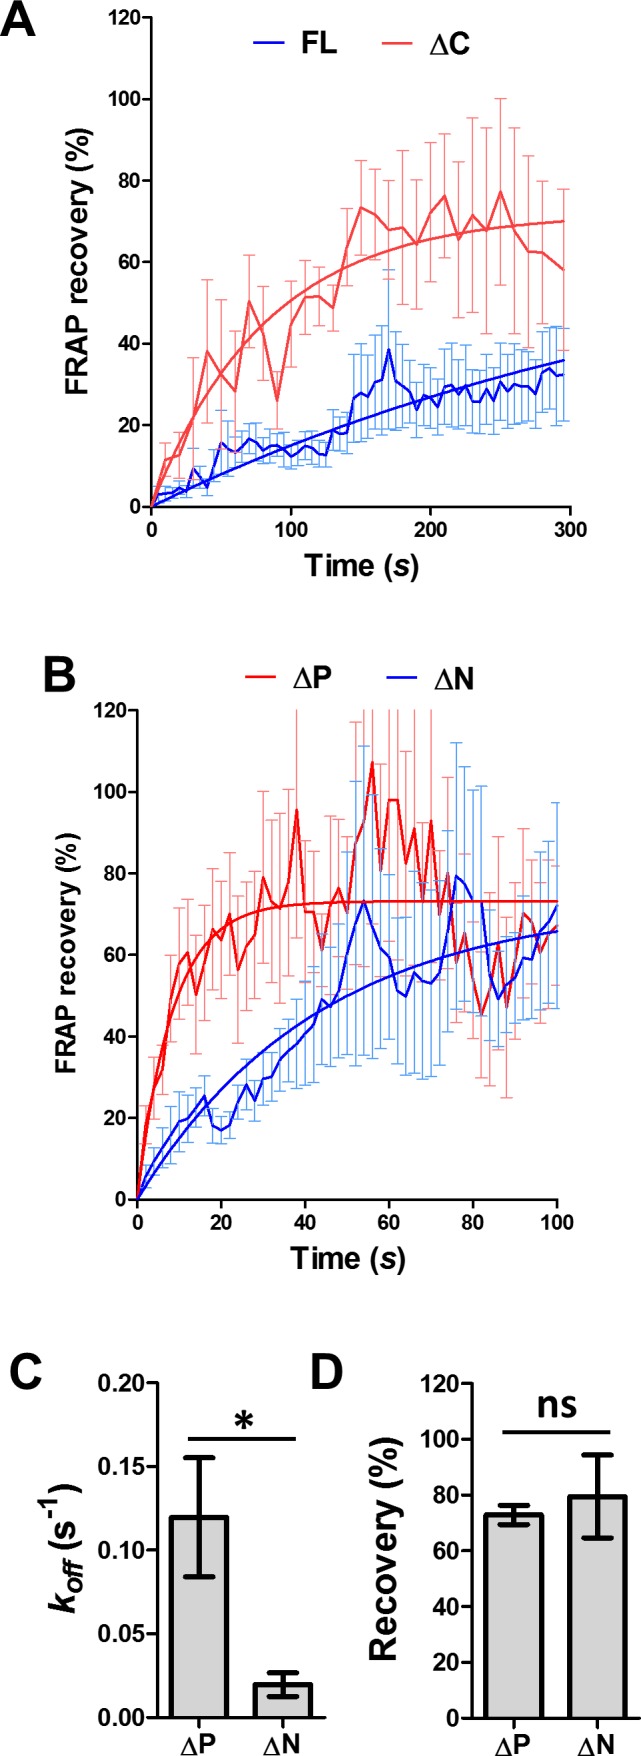
FRAP analysis of MAP7 binding to microtubules in COS cells.(A, B) FRAP recovery plots for FL-EGFP and ΔC-EGFP (A) or ∆P- and ΔN-EGFP (B) in COS cells. Solid lines are derived from non-linear curve fitting. (C, D) Comparison of the off-rate constant (kof) and the total recovery derived from curve fitting in C between ∆P- and ΔN-EGFP. n = 564 for ∆P (12 cells) and 449 for ΔN (10 cells). T-test (Mean ±SEM): p=0.014 (C) and p=0.635 (D). *p<0.05; and ns: not significant.10.7554/eLife.36374.012Figure 4—figure supplement 1—source data 1.Data for the fluoresence recovery curve (A,B) and the kinetic parameters (C,D) in Figure 4—figure supplement 1.